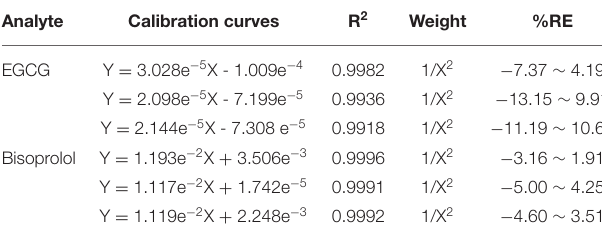
determined by HPLC-MS (weight W = 1/X 2 ).